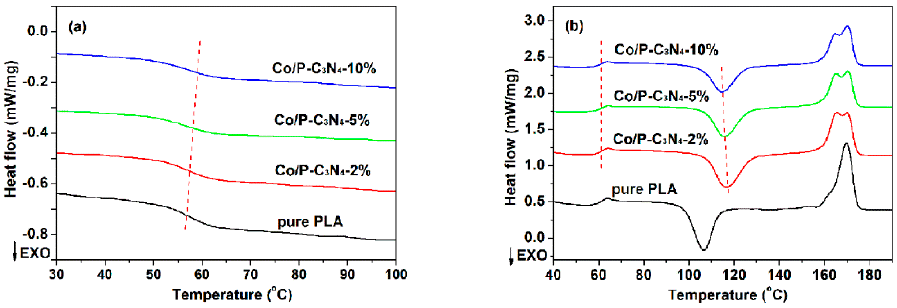
Figure 4. DSC curves of pure PLA and PLA composites. ( a ) First cooling, ( b ) second heating. Table 2. DSC data of PLA composites.